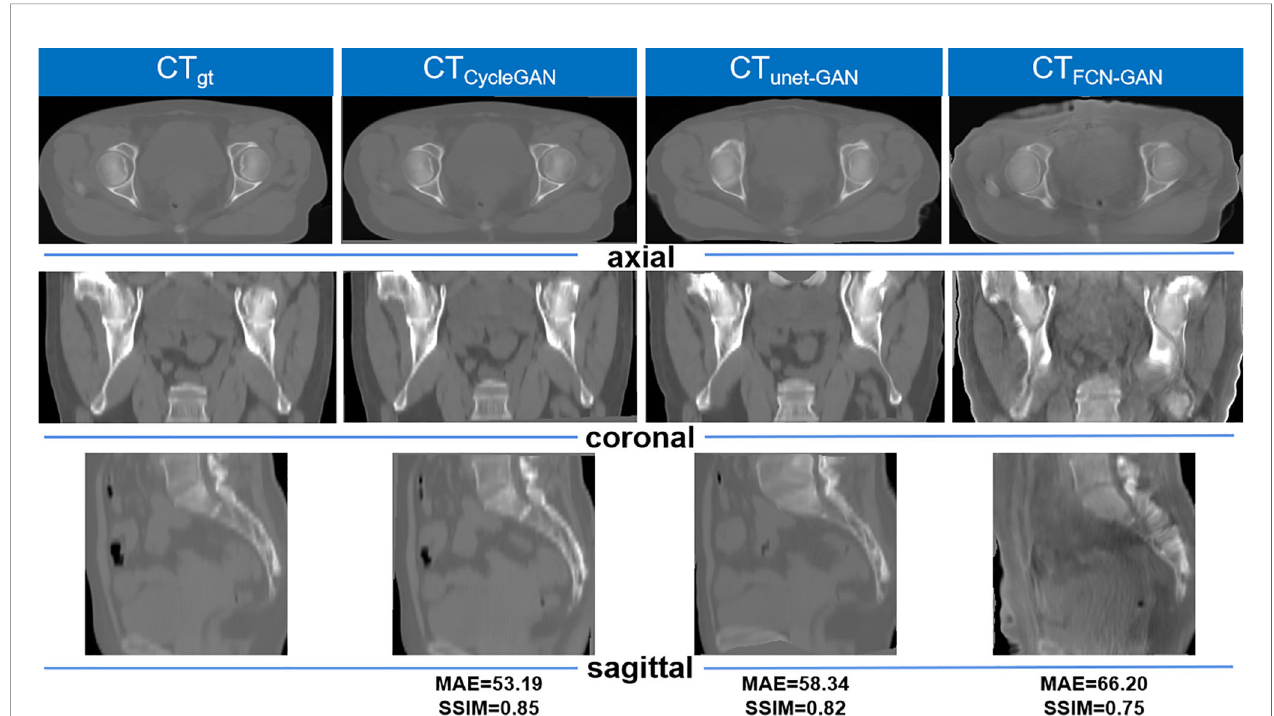
FIGURE 4 | Comparison of the results of CT gt images and pseudo-CT images obtained based on different deep learning methods in the axial, coronal, and sagittal directions. CT gt : The real CT images. CT CycleGAN : Pseudo CT obtained based on CycleGAN. CT unet-GAN : Pseudo CT obtained by GAN with U-net generator. CT FCN-GAN : Pseudo CT obtained by GAN with FCN generator. MAE: mean absolute error. SSIM: structural similarity coef fi